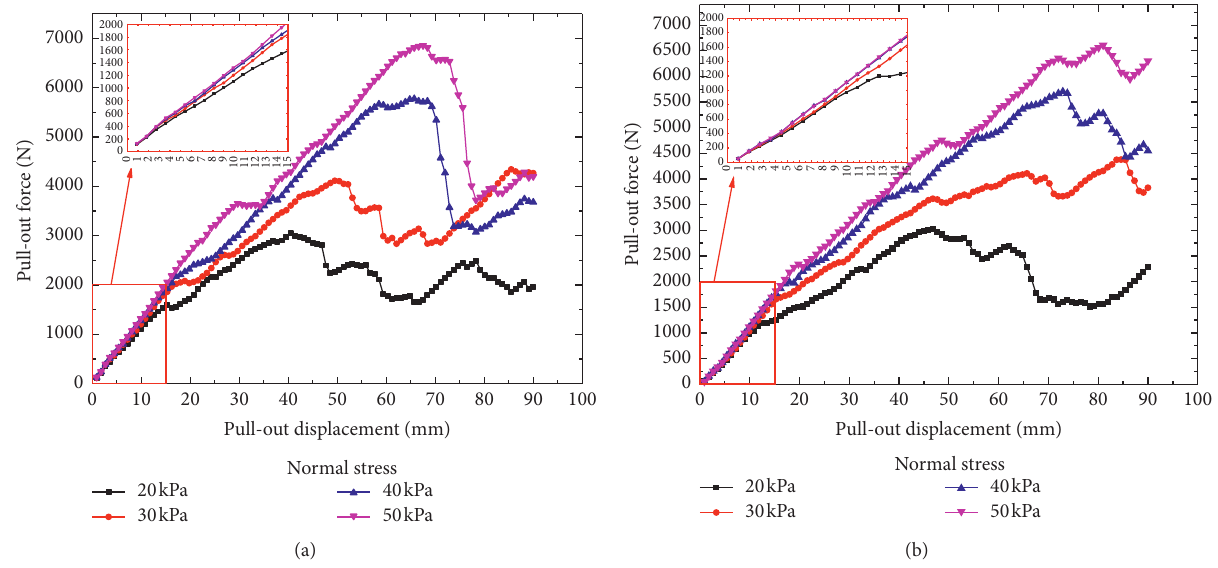
Figure 4: Pull-out force against pull-out displacement under different normal stresses: comparison of (a) BG1 and (b) TG1.